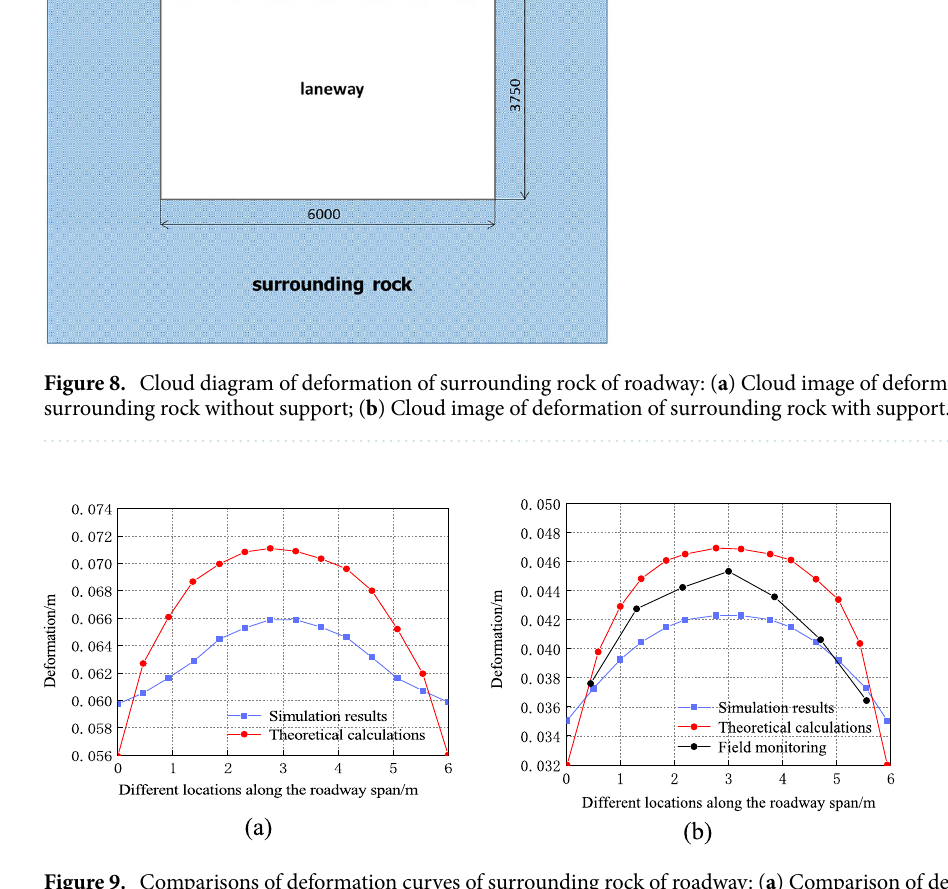
Figure 9. Comparisons of deformation curves of surrounding rock of roadway: ( a ) Comparison of deformation curves of roof surrounding rock without support; ( b ) Comparison of deformation curves of roof surrounding rock with roadway